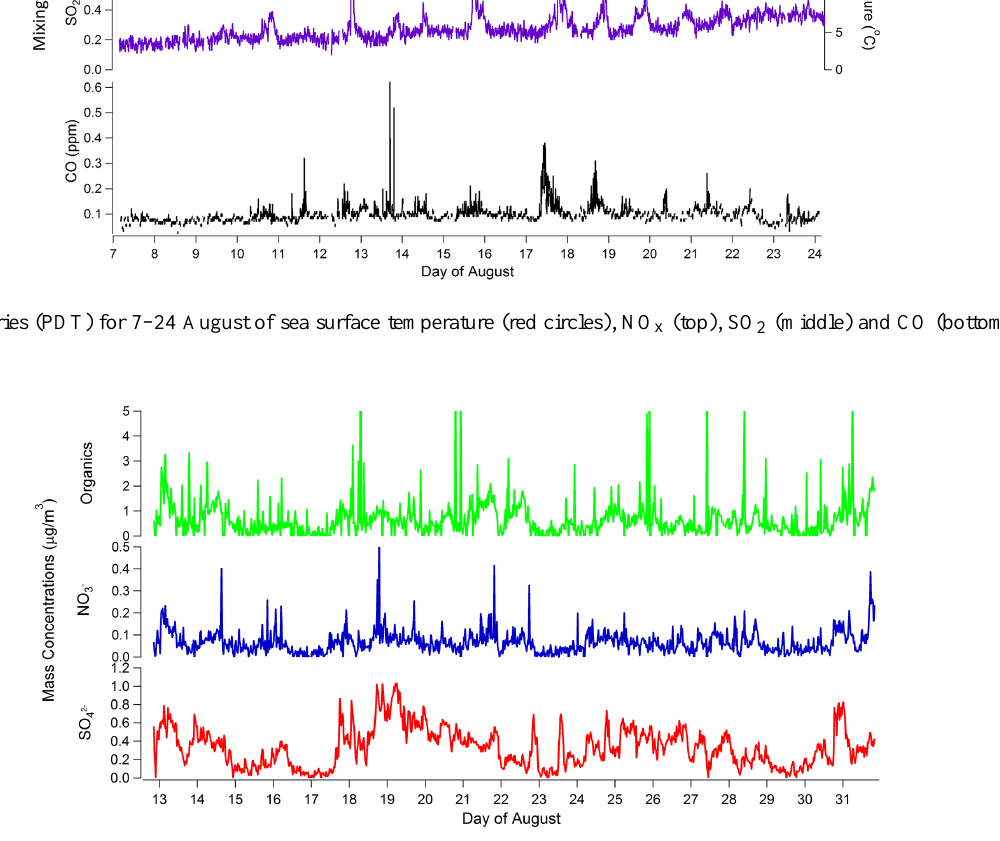
(blue) and SO 2 − (red). The maximum organic mass 3 4